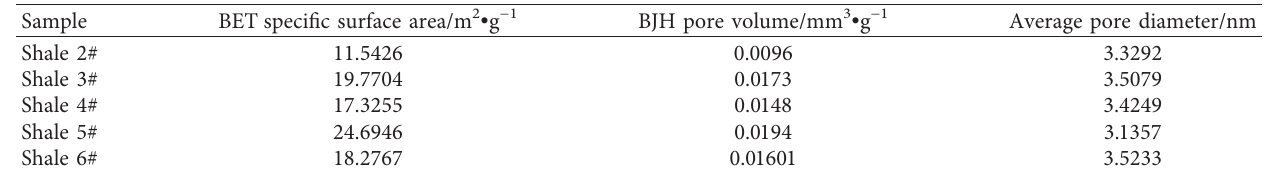
Table 3: Pore structure parameters of shale samples.